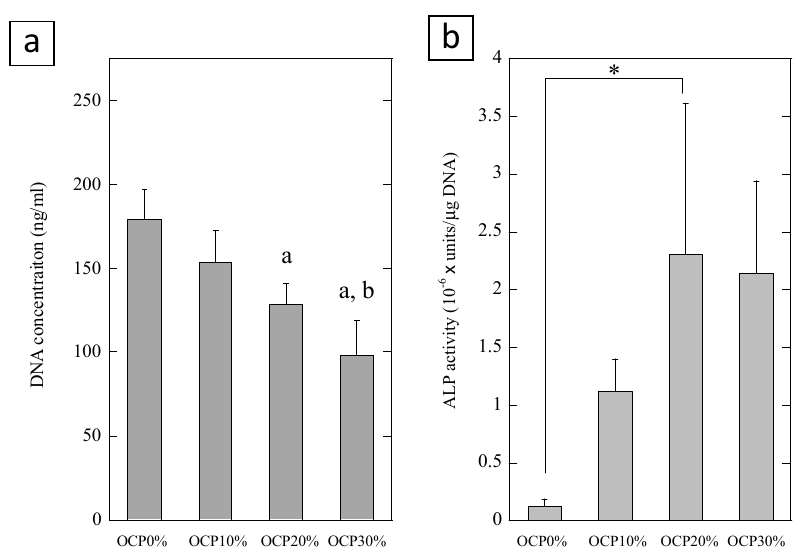
Figure 2. Cell proliferation ( a ) and alkaline phosphatase (ALP) activity ( b ) of C3H10T1/2 cells cultured on the GelMA hydrogel containing different amounts of octacalcium phosphate (OCP) (0, 10%, 20%, 30%) at day 14. Error bars show standard deviation. a statistical significance p < 0.05 compared with OCP0%, b statistical significance p < 0.05 compared with OCP10%, * statistical significance p < 0.05, Tukey-Kramer test, n = 3.